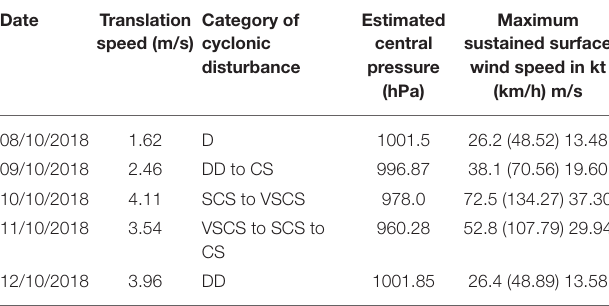
TABLE 2 | Daily mean characteristics of the cyclone Titli in the Bay of Bengal (BoB) during its genesis and